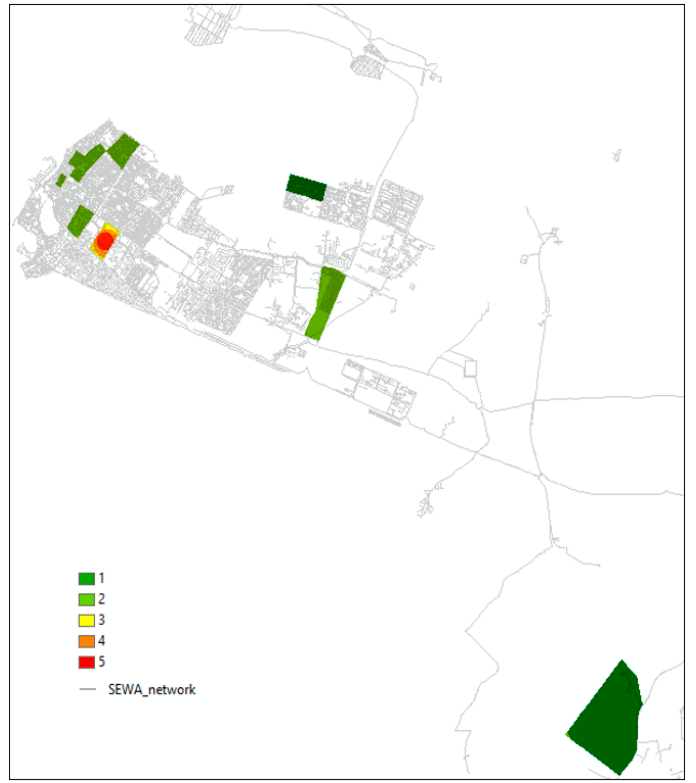
Figure 5. Physical parameters; friction factor map .